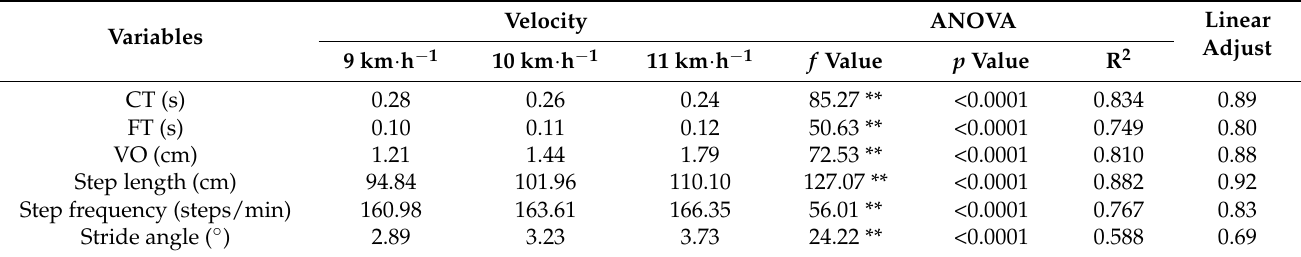
Table 2. Repeated measurements ANOVA. Effect of velocity on spatiotemporal